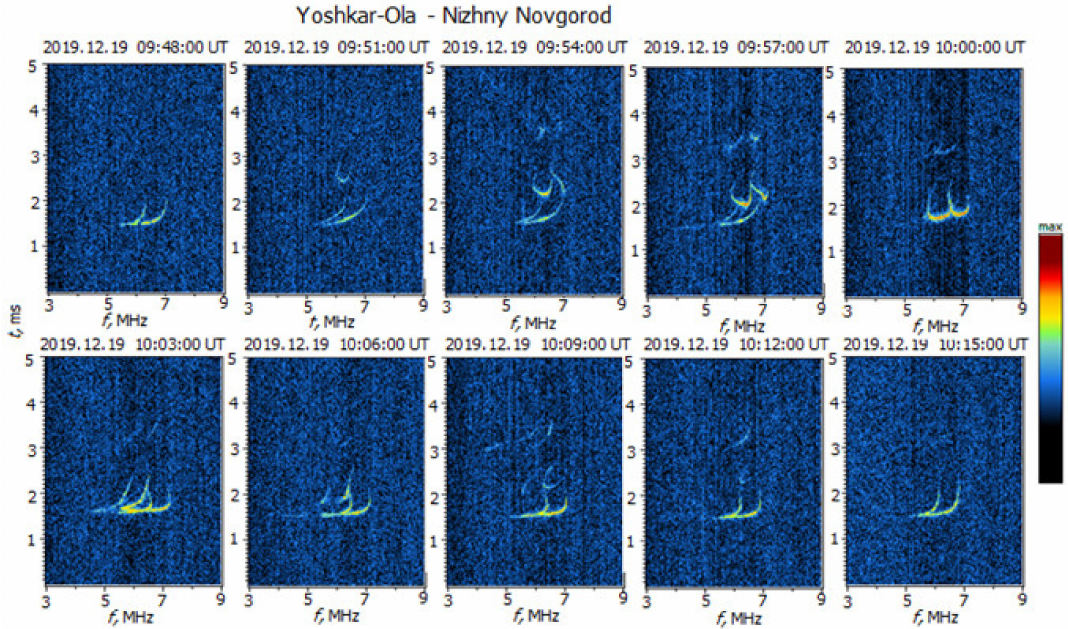
Figure 6. Illustration of the TID movement “top-down” ( upper panel ) and “bottom-up”( low panel ) on the Yoshkar-Ola-Vasilsursk